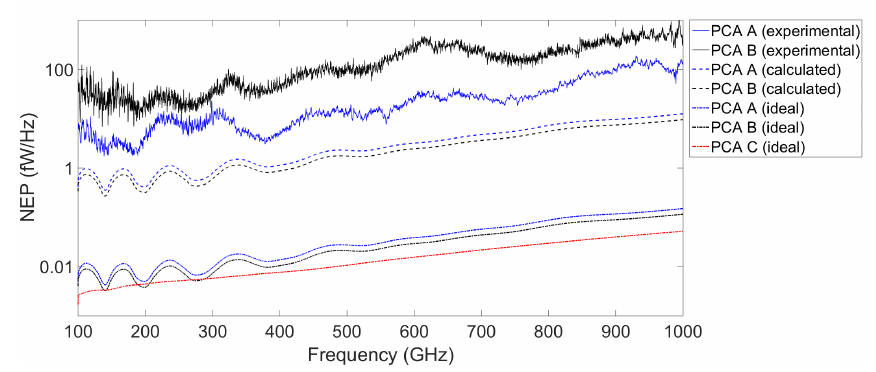
Figure 6. Comparison between the calculated ( η ef f I noise = I therm ), and the experimentally obtained NEPs for PCA A and B. The figure also shows the ideal performance of PCA